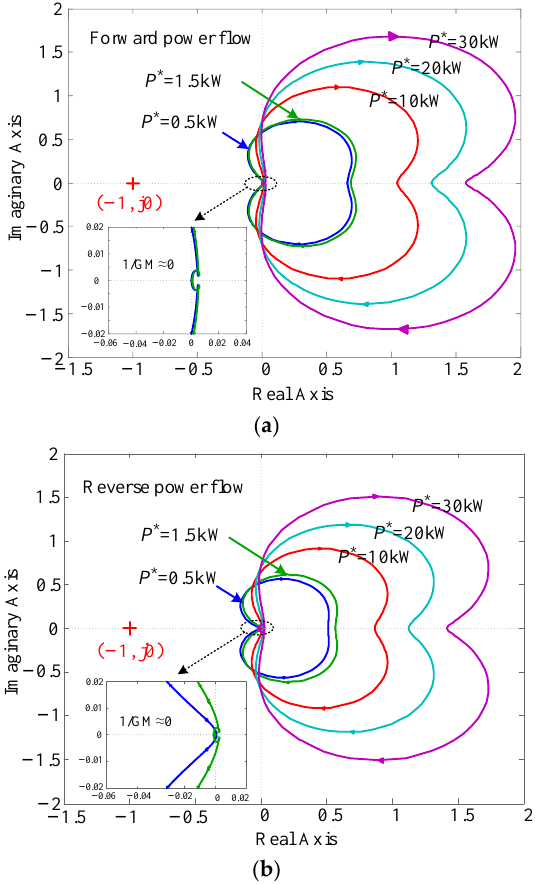
Figure 12. Nyquist plots obtained with power increased with IRSE control: ( a ) in forward power direction; ( b ) in reverse power direction.